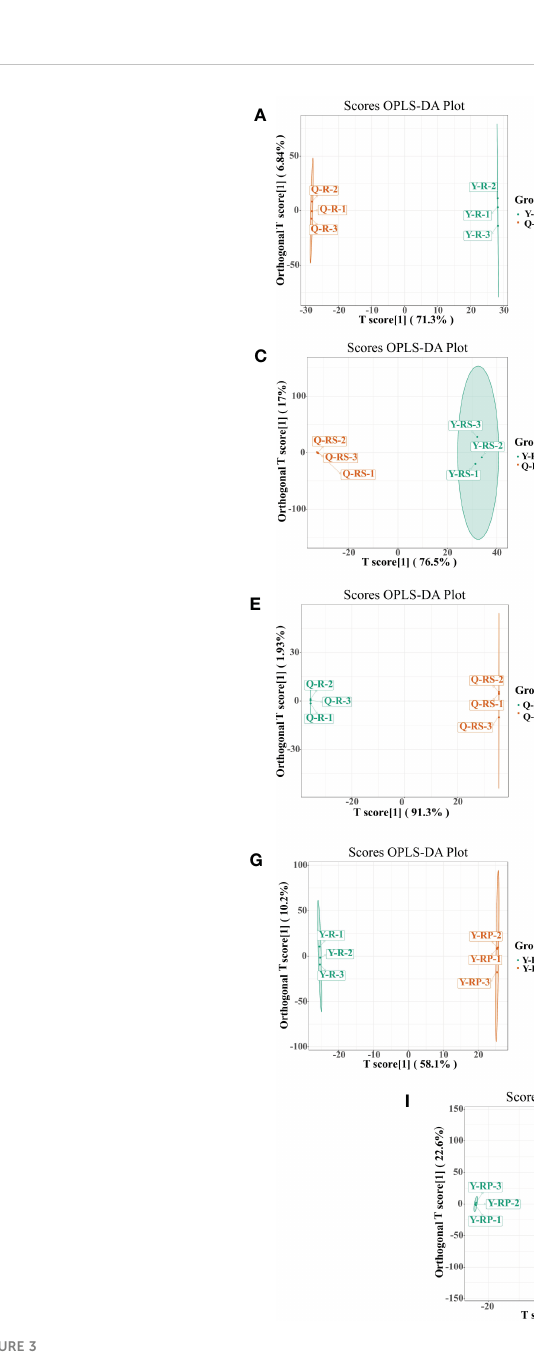
FIGURE 3 The OPLS-DA score plots of. OPLS-DA model plots for the comparison groups, Y-R vs Q-R, Y-RP vs Q-RP, Y-RS vs Q-RS, Q-R vs Q-RP, Q-R vs Q-RS, Q-RP vs Q-RS, Y-R vs Y-RP, Y-R vs Y-RS, and Y-RP vs Y-RS (A – I)